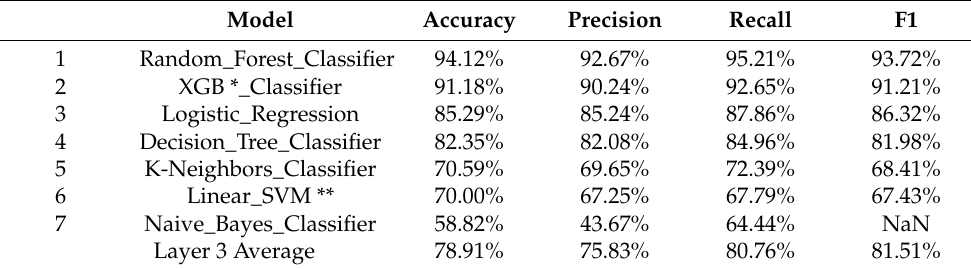
Table 6. Layer 3—Accuracy. Figure 5. Layer 2 for prediction of extraction and non-extraction treatment for jaw base I — accuracy. * XGB — eXtreme Gradient Boosting. ** SVM — Support Vector Machine. Table 6. Layer 3 — Accuracy.